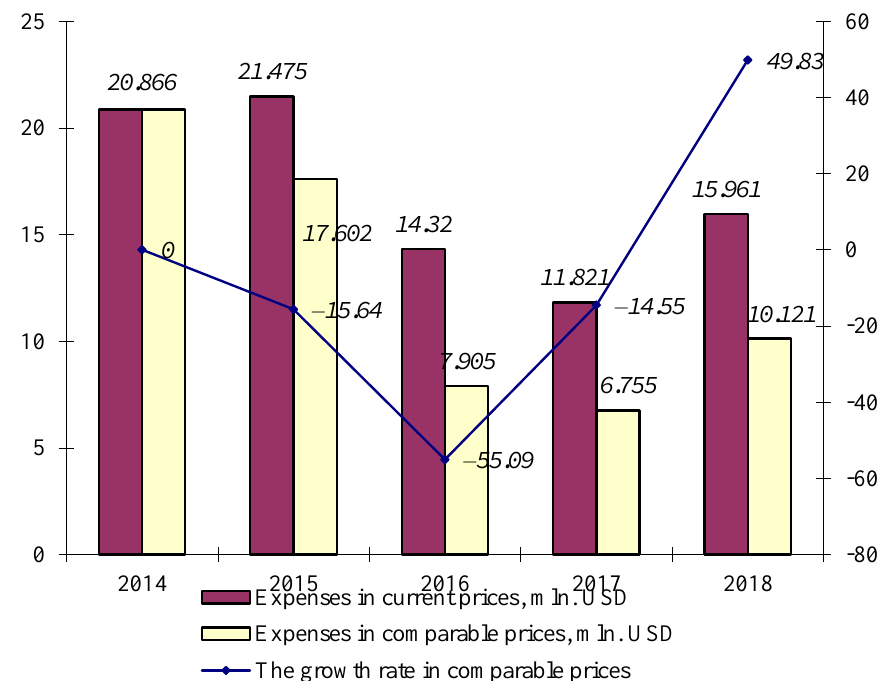
Fig. 4. The dynamics of government spending on the purchase of anti-TB D in US